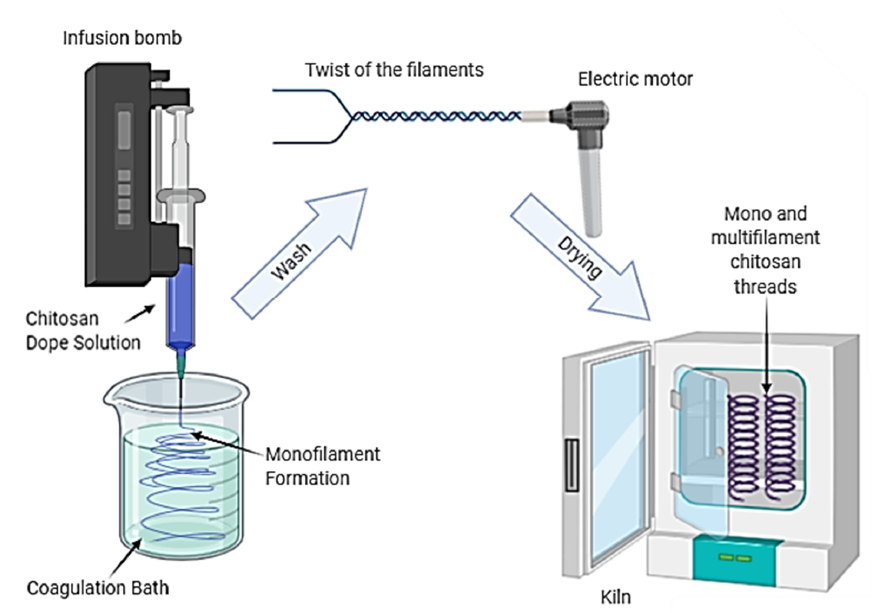
Figure 1. Schematic representing the preparation of the chitosan mono- and multifilament threads by wet-spinning followed by twisting.